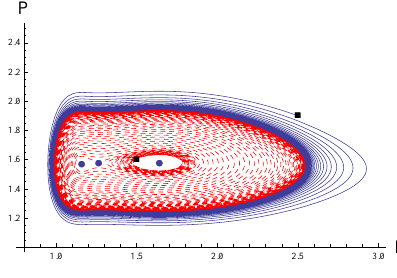
(b) Example 10. Dynamics of the model in the vicinity of E 1 and E 3 . A limit cycle exists around E 3 . Two trajectories are depicted— with a dashed and a solid line. The black squares denote the corresponding initial con- ditions. P